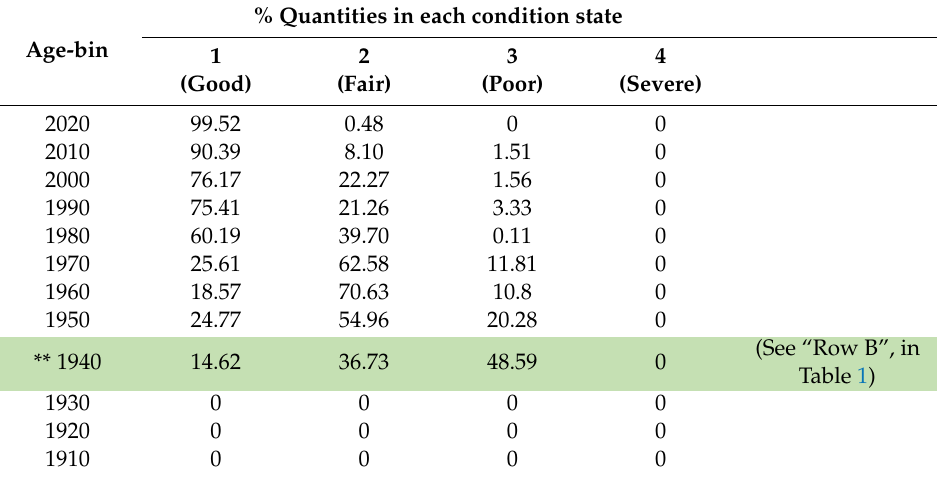
Table 2. Percentage quantities for element 12 (reinforced concrete deck).